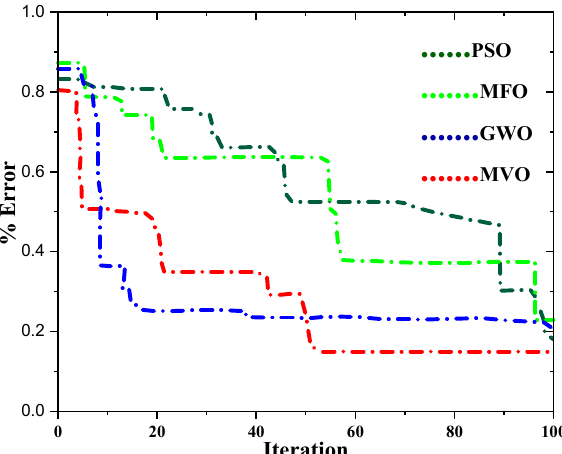
Figure 3. Convergence curve of multiverse optimization (MVO) in comparison with other meta-heuristic algorithms.